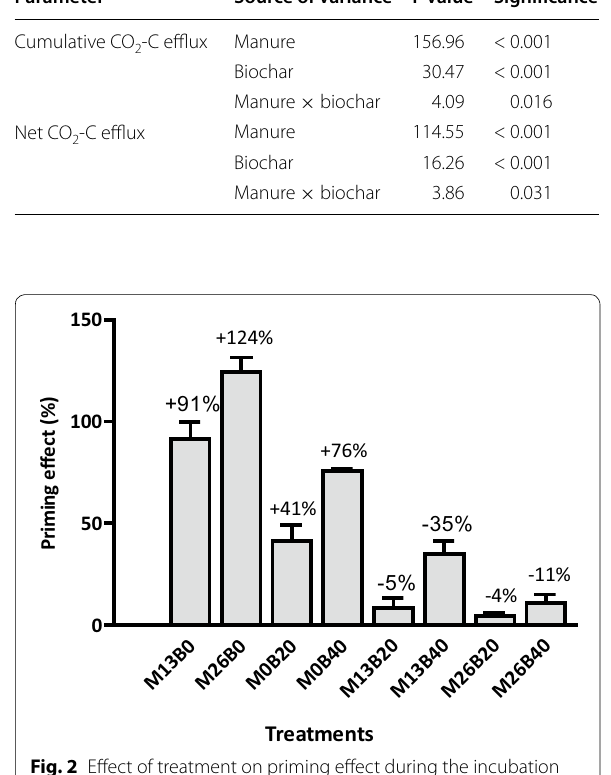
Fig. 2 Effect of treatment on priming effect during the incubation of sandy soils amended with cow manure (M), biochar (B) and B–M mixtures over 56 days. Same letter(s) above the bars indicate no significant difference between treatments at p 0.05. Vertical bars = represent standard error of the mean (n 3). M0, M13 and M26 are = M rates at 0, 13 and 26 tons ha − 1 respectively. B0, B20 and B40 are B rates at 0, 20 and 40 tons ha − 1 ,